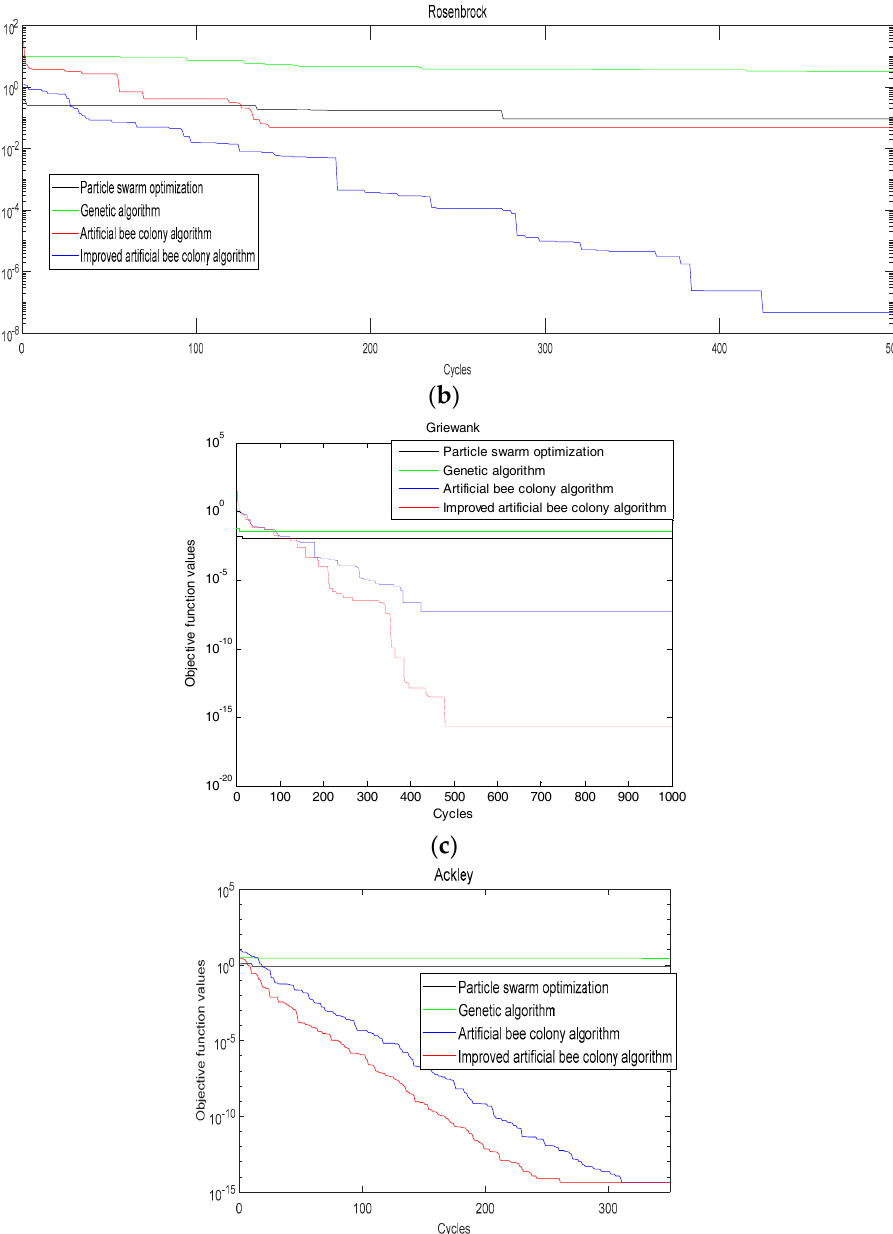
Figure 2. Evolution curve of each function. ( a ) Sphere function; ( b ) Rosenbrock function; ( c ) Griewank function; and ( d ) Ackley function.